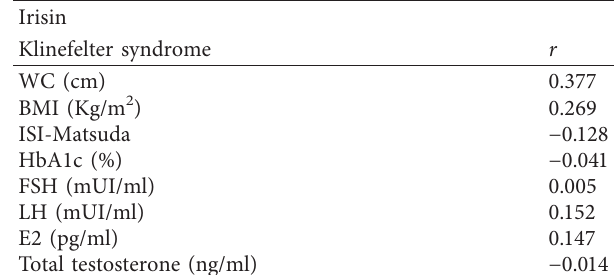
Table 2: Correlation between Irisin and clinical and hormonal metabolic parameters (univariate analysis) in patients with Kli- nefelter